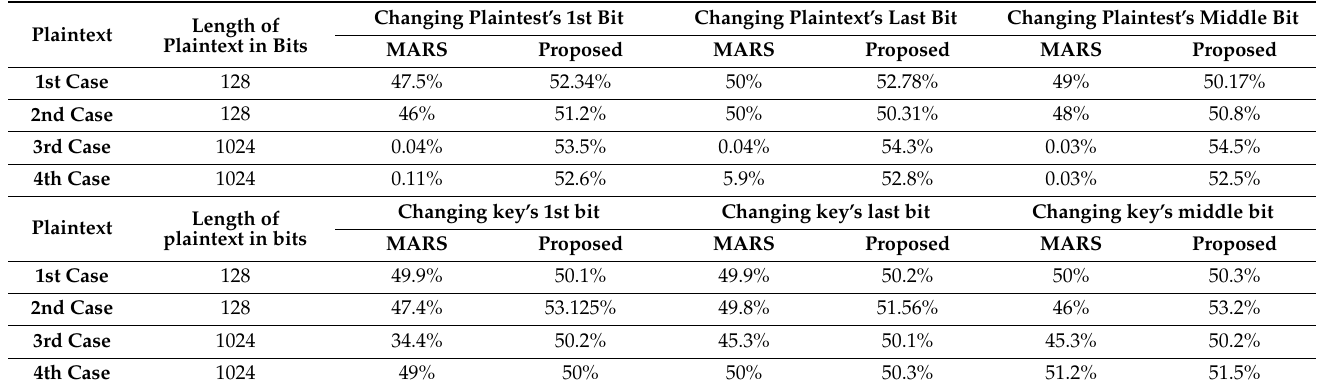
Table 3. The effect of avalanche.